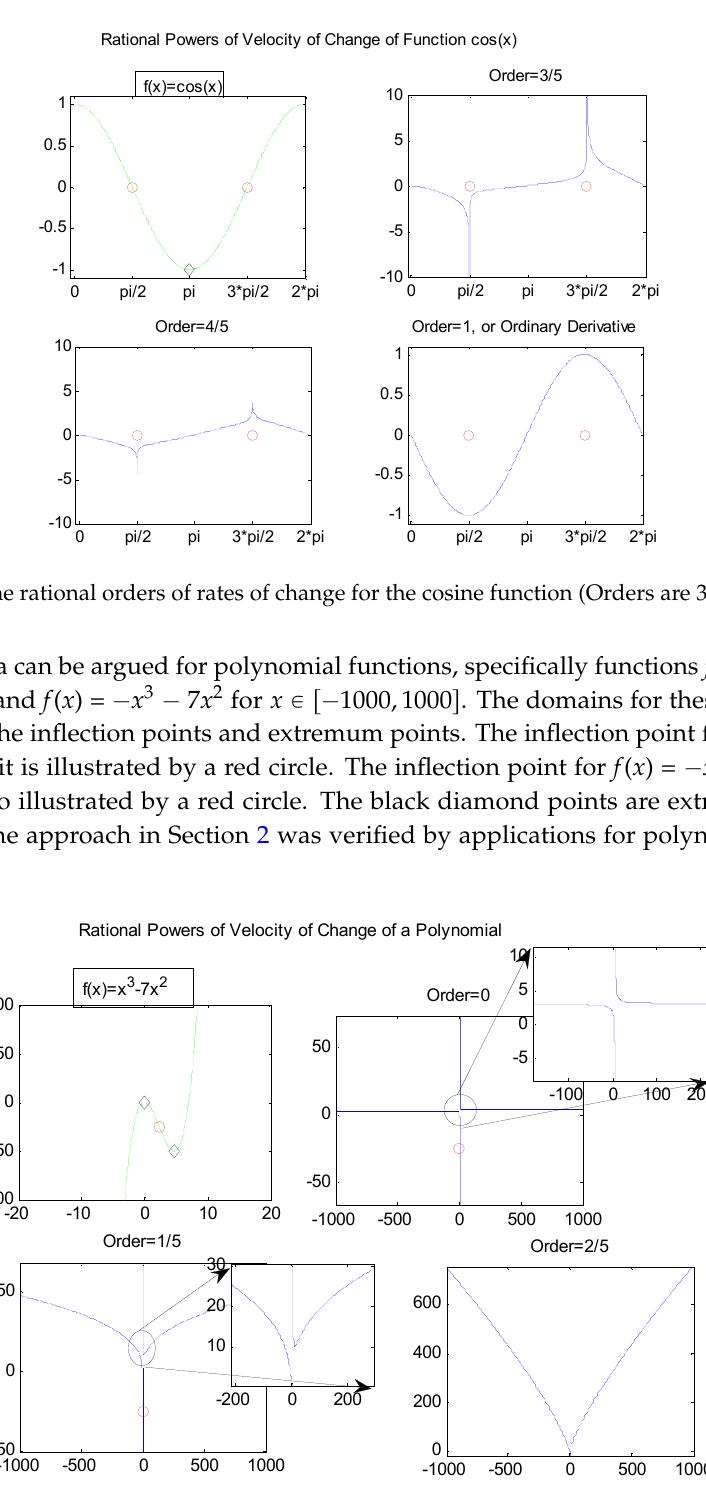
Figure 6. The rates of change for f ( x ) = x 3 − 7 x 2 orders {0, 1/5, 2/5}.